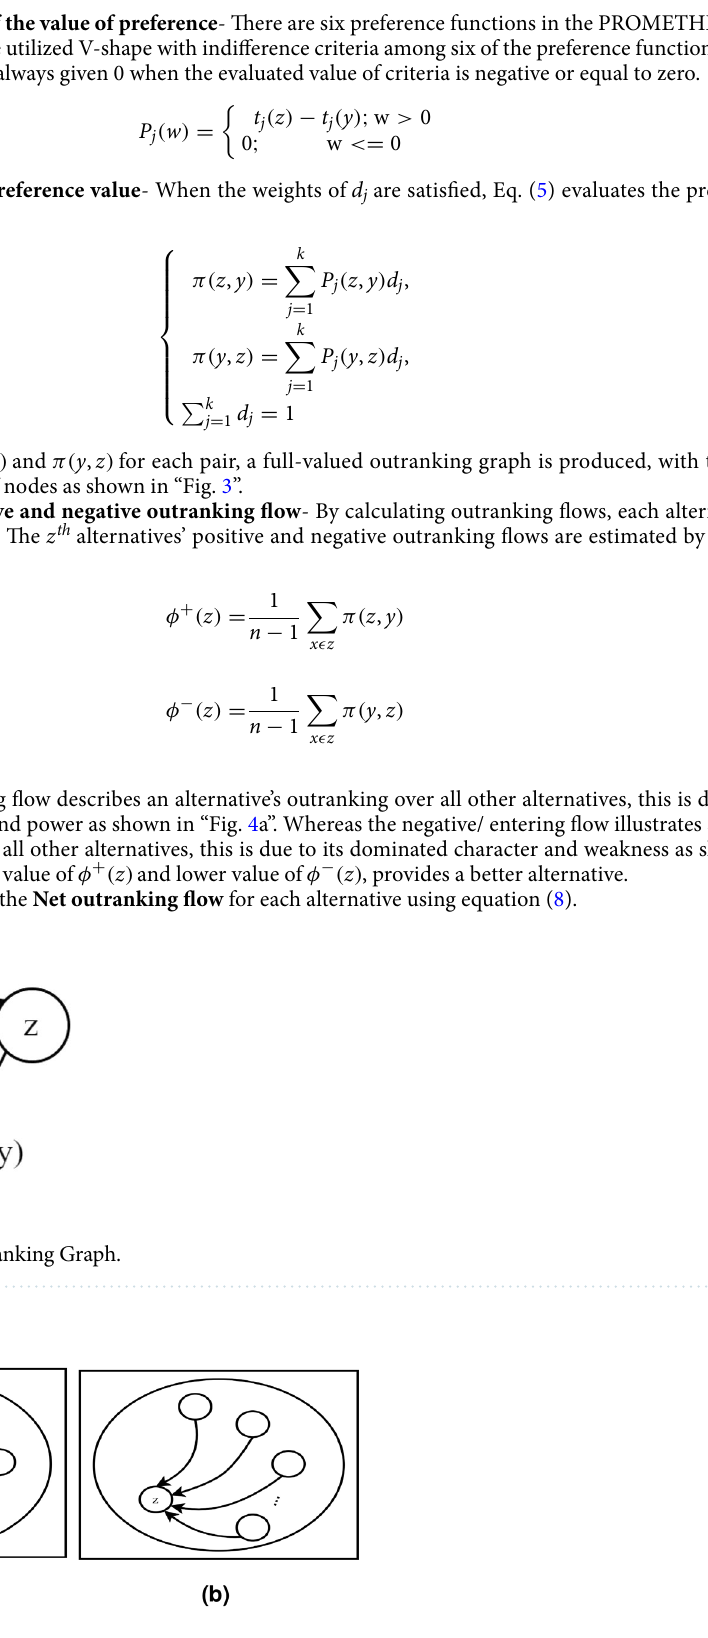
Figure 4. The φ + ( z ) and φ − ( z ) Outranking